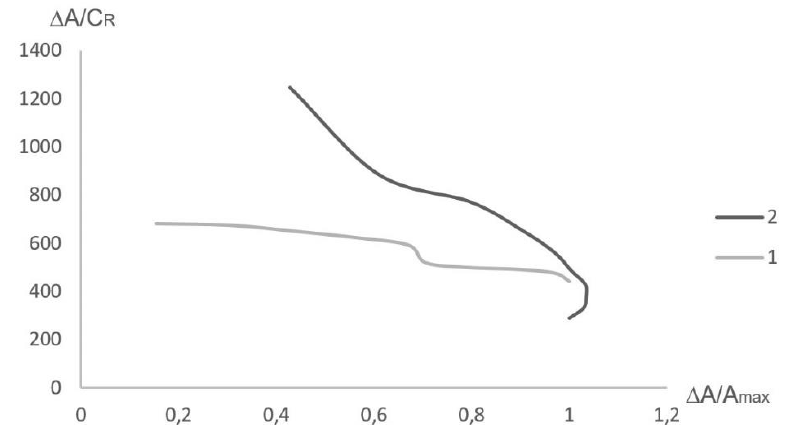
Fig. 4. Curves of the relative yield of "lamotrigine - diazole red 2J" reaction product: 1 – at a constant concentration of diazole red 2J (1.00 ml of 0.001 M solution); 2 – at a constant concentration of lamotrigine (1.00 ml of 0.001 M solution) at λ =370 nm max